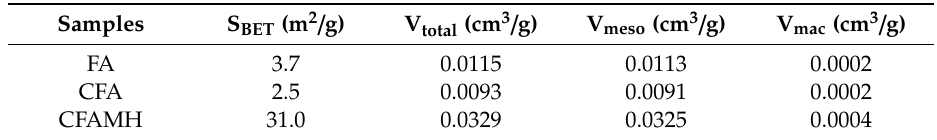
Figure 2. SEM photographs of ( a ) fly ash (FA), ( b ) calcined fly ash (CFA), ( c ) calcined fly ash coated with magnesium hydroxide (CFAMH) × 5000, ( d ) CFAMH × 50,000, ( e ) magnesium hydroxide (MH) × 25,000 and ( f ) EDS of CFAMH. Table 1. Specific surface areas and pore characteristics of fly ash (FA), calcined fly ash (CFA) and calcined fly ash coated with magnesium hydroxide (CFAMH) powders.